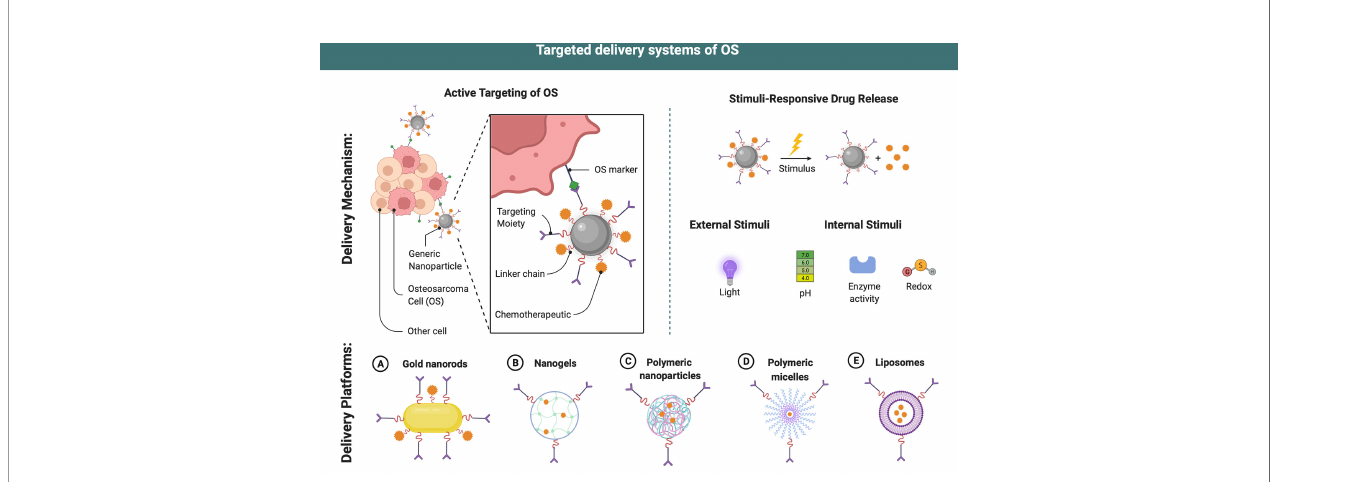
FIGURE 3 | Targeted delivery systems of OS. Different delivery systems have ideal properties for chemodrugs transport and delivery. Targeting ligands may be attached to the surface allowing an active targeting strategy and an increase in ef fi ciency of the therapeutic payloads in OS therapy. After internalization, dissociation occurs at a proper microenvironment due to different stimuli (enzyme, redox, etc.), drug payloads are released into the cytosol of cancer cells. This fi gure was created with